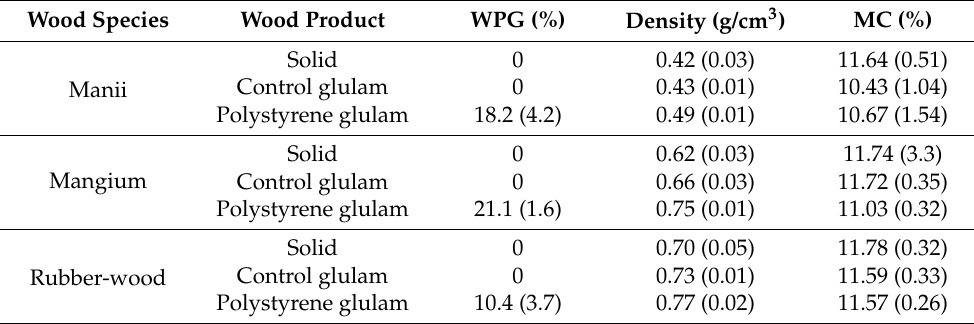
Table 3. Physical properties of wood species and wood products.